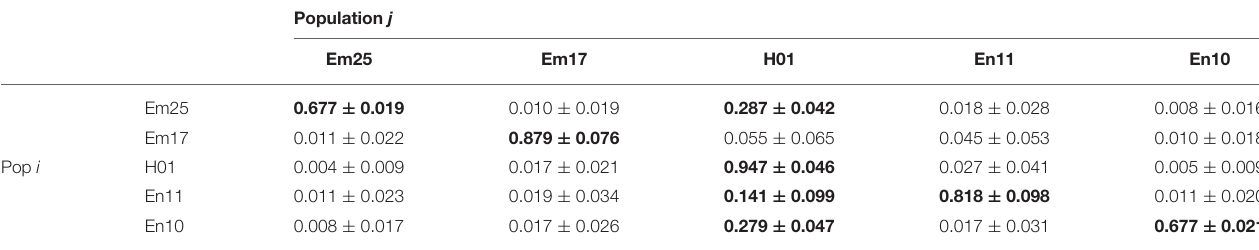
TABLE 5 | Recent migration rates ( m ij ) and SEs from i populations to j populations in the transect between E. mediohispanicum and E. nevadense, inferred from the variation at 10 microsatellite DNA loci using